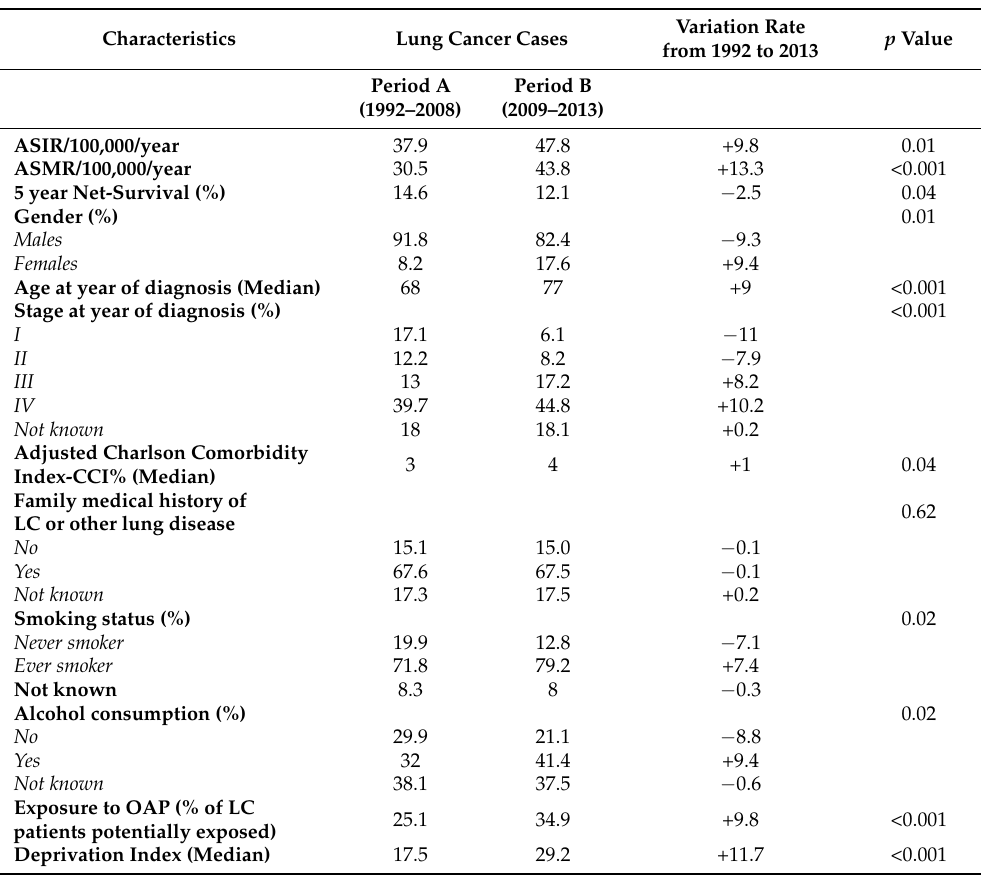
Table 1. LC burden in Crete and the demographic, clinical, socioeconomic, and environmental profiles of the under-study population before and after the economic crisis, ( n =